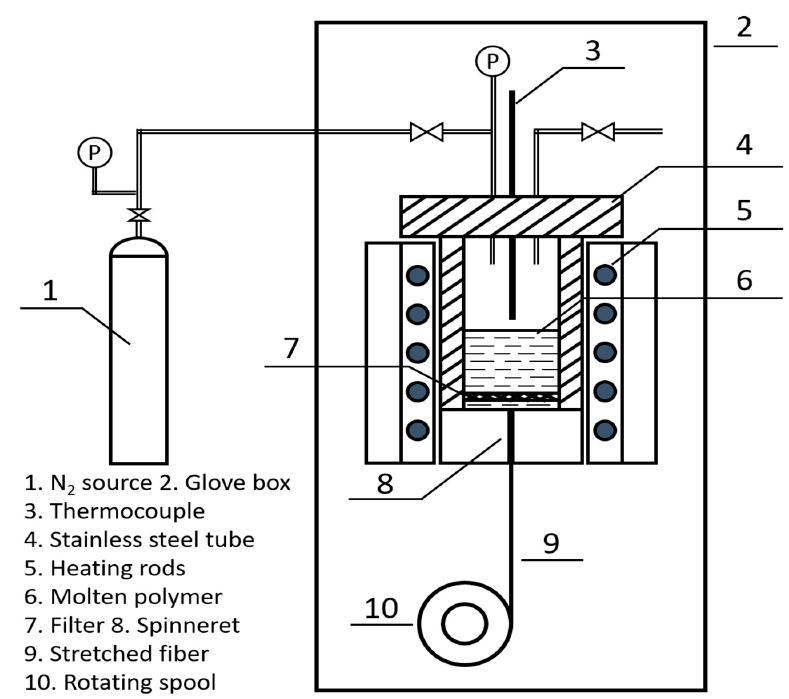
Figure 1. Schematic diagram of the melt-spinning apparatus.